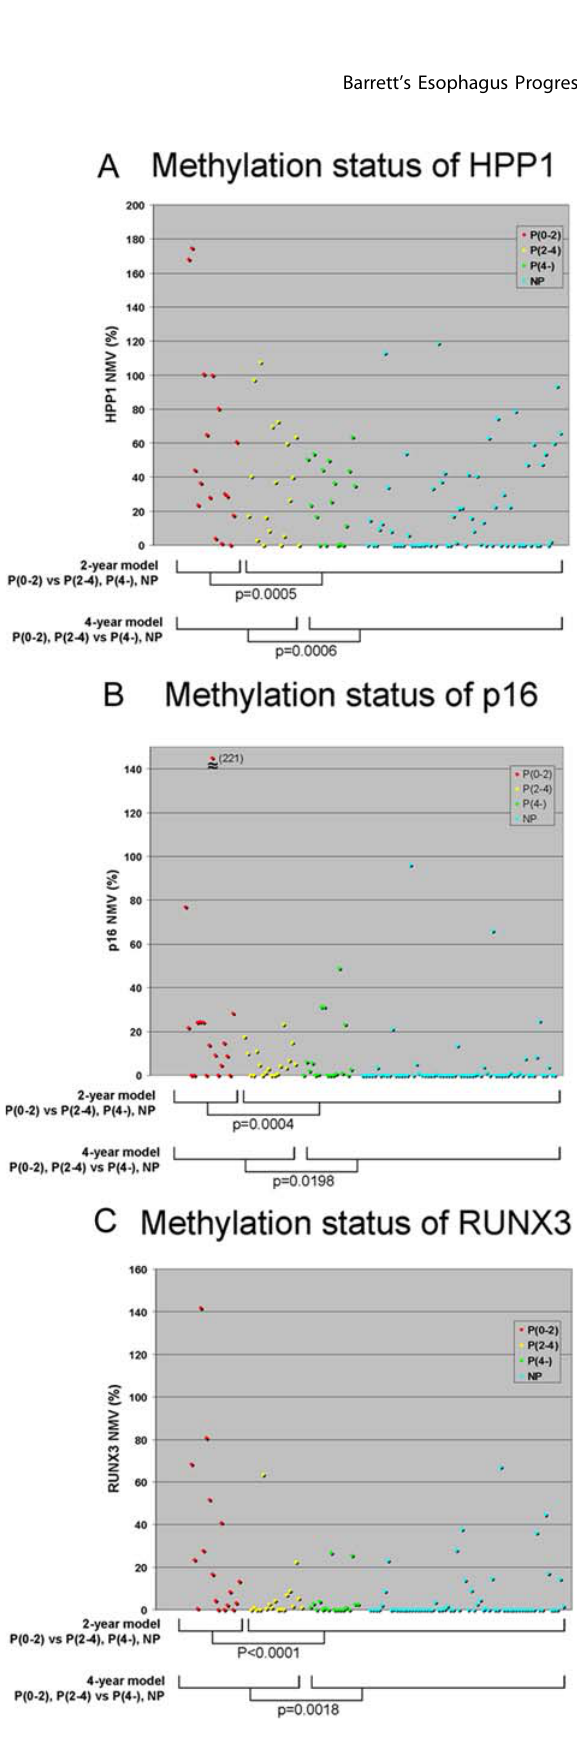
Figure 2. Methylation status of HPP1, p16, and RUNX3. Normalized methylation values (NMVs) of HPP1 ( 1A ), p16 ( 1B ), and